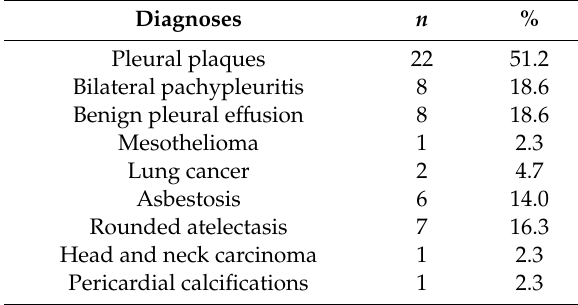
Table 2. Description of asbestos-related diseases in 43 participants.